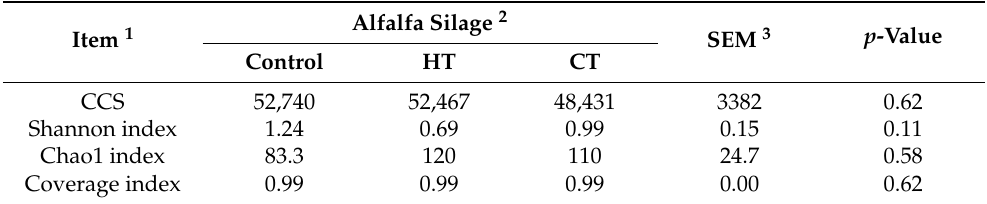
Table 2. Alpha diversity of alfalfa